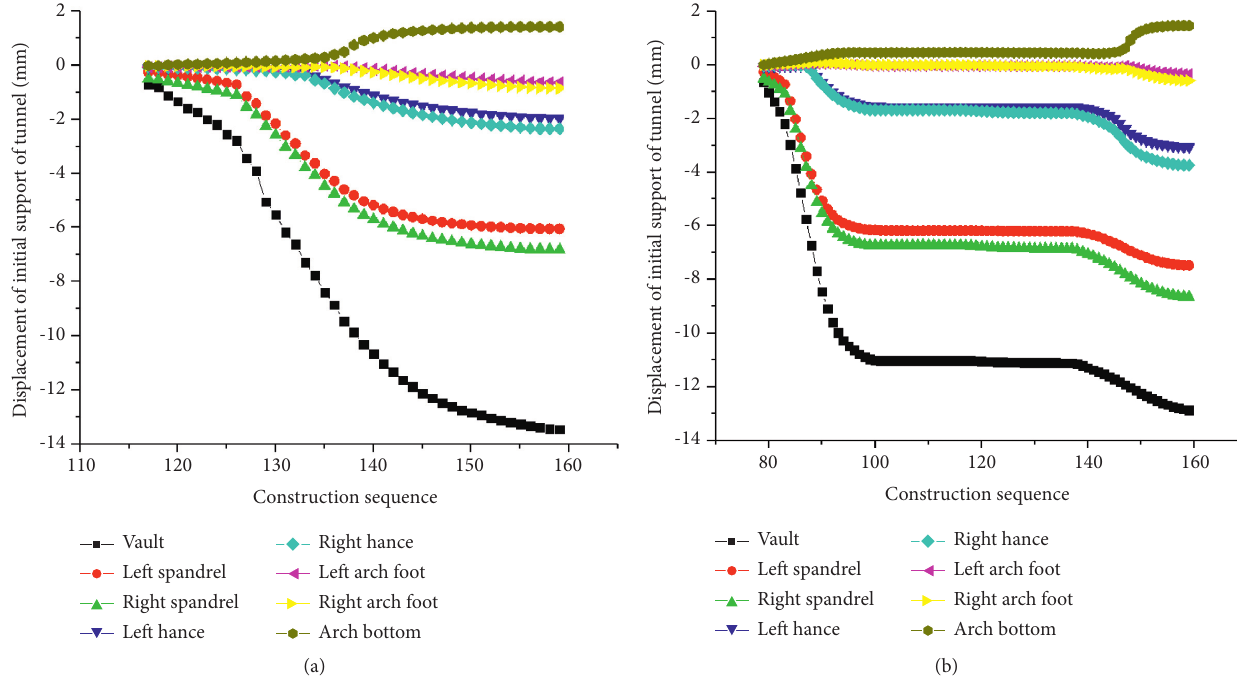
Figure 7: Time-history curves of tunnel initial support displacement under different schemes. (a) Time-history curve of tunnel initial support displacement in scheme I. (b) Time-history curve of tunnel initial support displacement in scheme